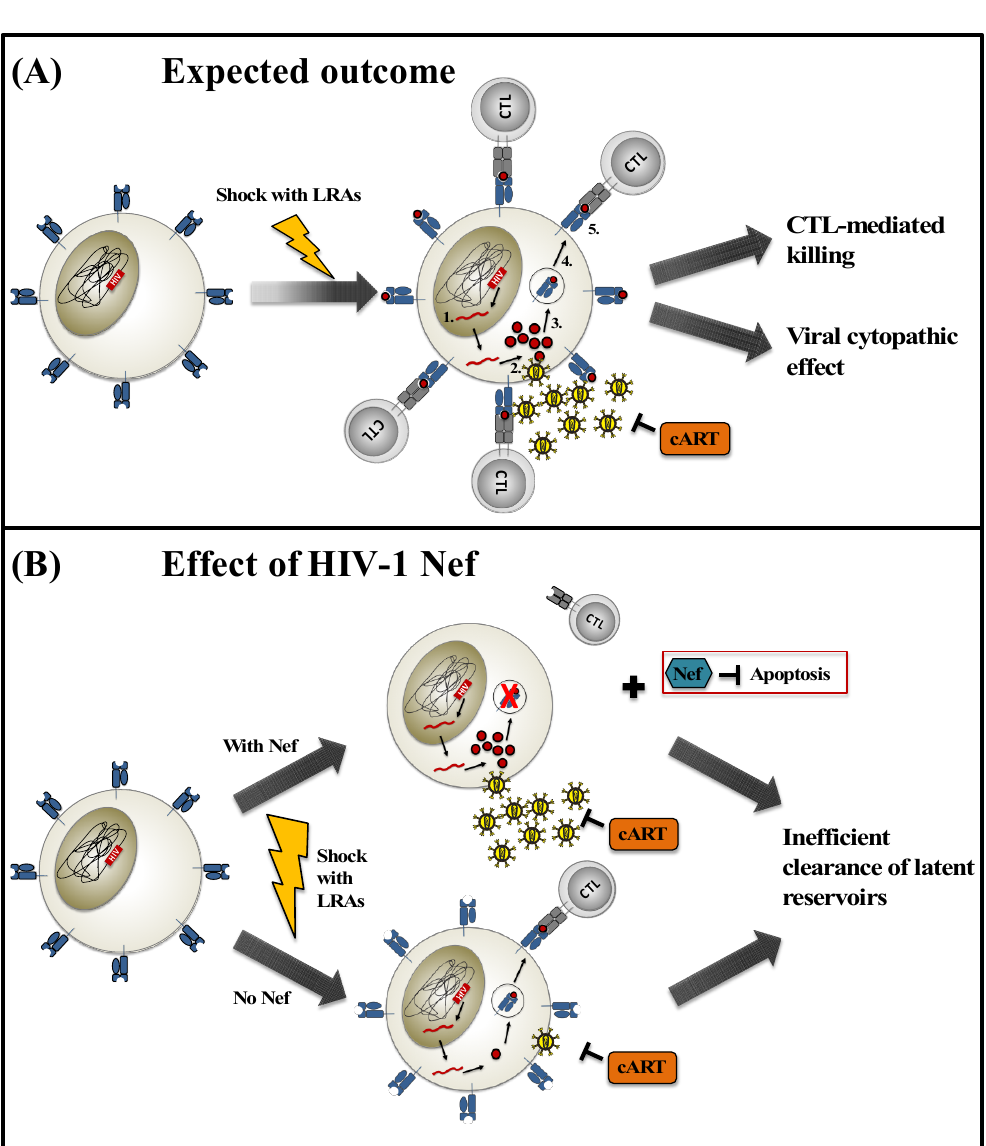
Figure 1. Impact of Nef on “shock and kill” methods to eradicate HIV reservoirs. ( A ) This illustration displays the expected outcome of a latent HIV-infected T cell following induction with latency-reversing agents (LRAs) (“shock”) in the presence of combination antiretroviral therapy (cART). The integrated HIV proviral genome is transcribed (1) and translated into viral proteins (2). Some viral proteins are degraded into peptide antigens and loaded onto HLA class I molecules (3) for presentation at the cell surface (4). The recognition of peptide-HLA complexes by cytotoxic T lymphocytes (CTL) (5) induces cytolytic mechanisms that kill the virus-infected cell. Alternatively, the expression of viral proteins may induce viral cytopathic effects that result in the death of the infected cell. ( B ) This illustration displays the potential contributions of the viral Nef protein to modulate the reactivation and elimination of latent HIV-infected cells by “shock and kill” methods. In the presence of Nef, viral protein expression is robust, but HLA class I molecules are down-regulated from the cell surface and cellular apoptosis is inhibited. In the absence of Nef, viral protein expression is reduced, thus limiting the amount of viral antigen that is available for presentation on HLA class I. In both scenarios, CTL-mediated recognition and elimination of newly reactivated HIV-infected cells may be hindered.